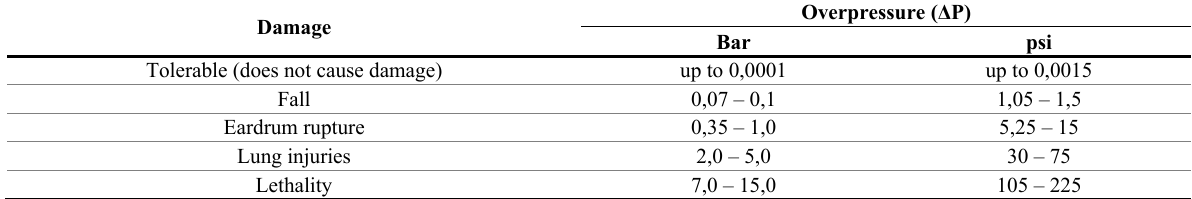
Table 3. List of some damages caused to humans